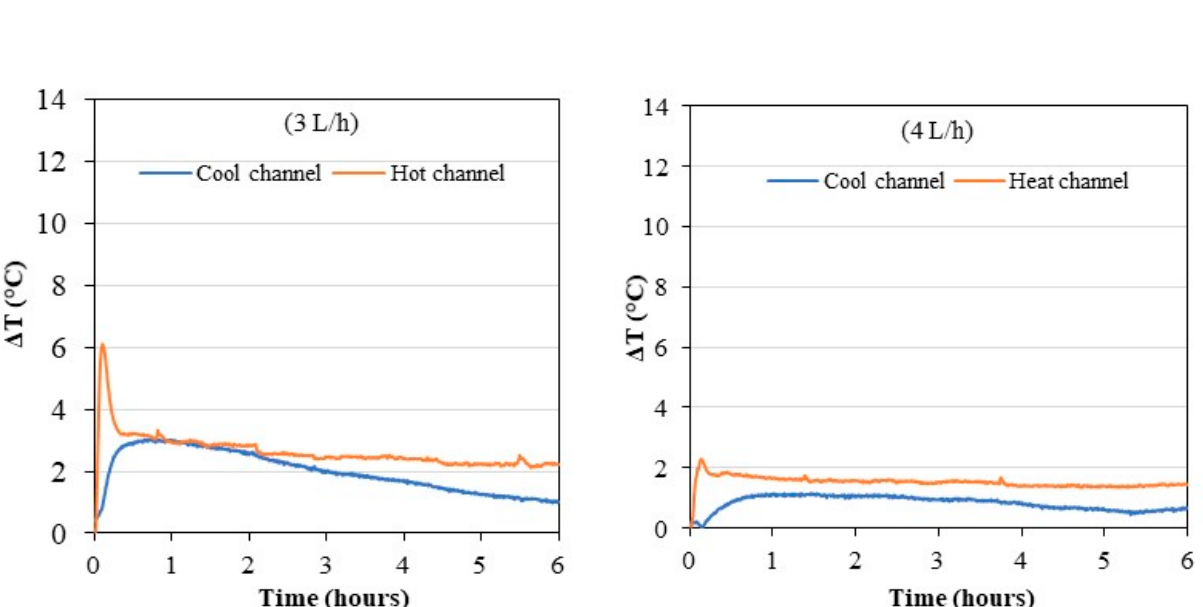
Figure 11. Evolution of the temperature differences of the channels at the different operating flow rates in continuous mode.